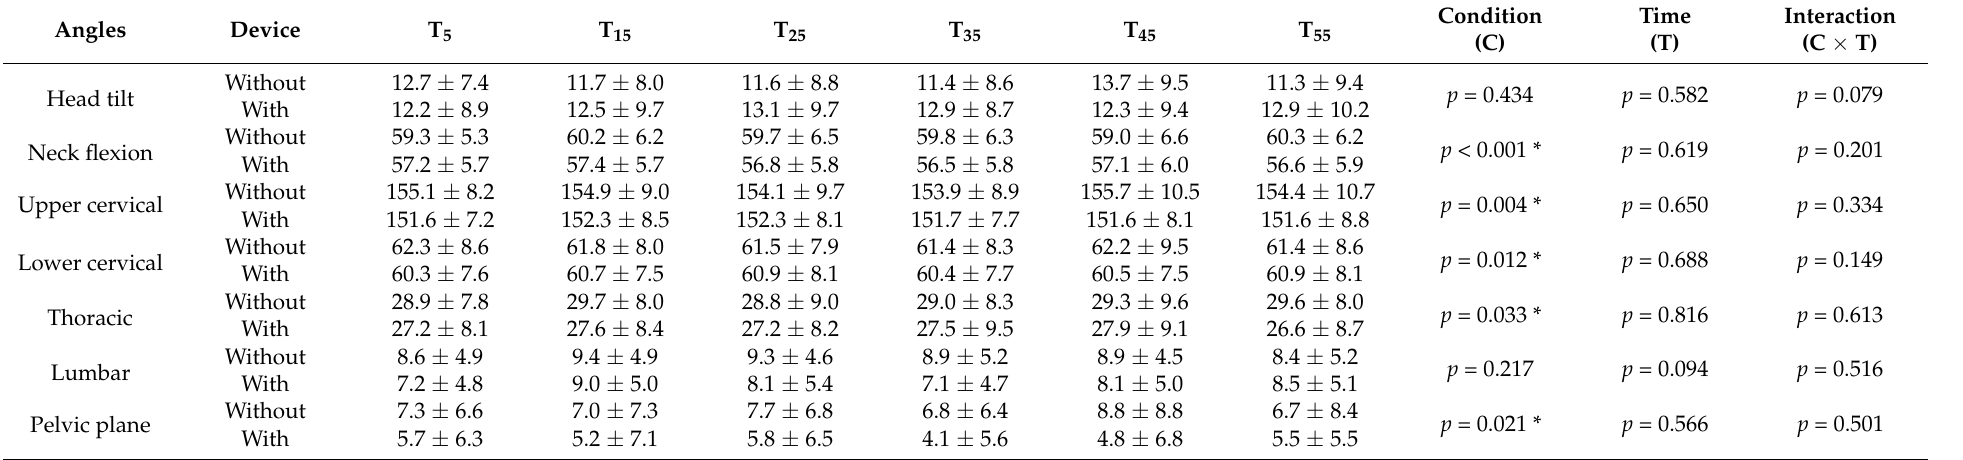
Table 1. Descriptive and inferential statistics of the spinal angles under two conditions across six time points (N =